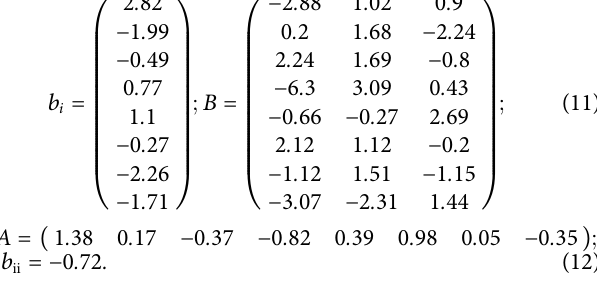
Frontiers in Bioengineering and Biotechnology |